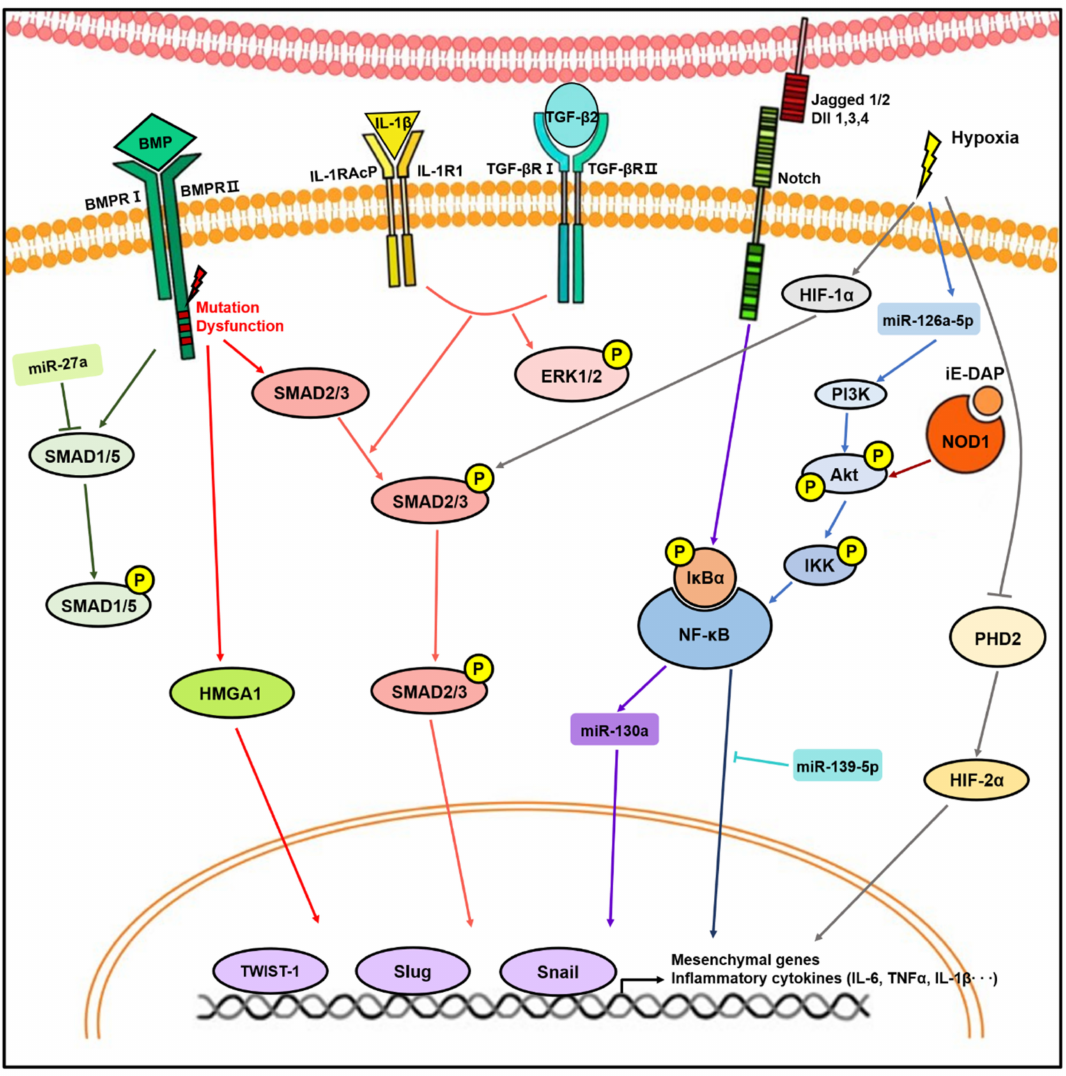
Figure 2. Molecular signaling pathways involved in endothelial-to-mesenchymal transition (EndMT). Stimulation with transforming growth factor- β (TGF β ), bone morphogenic protein (BMP), Notch ligands, inflammatory stress, and hypoxia induce expression of transcription factors, such as Twist1, Slug, and Snail, resulting in EndMT. During this process, mediators including microRNAs (miRNAs), Smad, Akt / nuclear factor kappa B (NF- κ B), and hypoxia-inducible factor (HIF) play important roles in